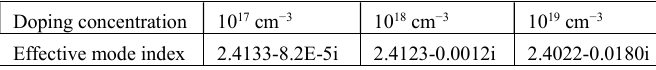
Table 1. Effective mode index for three different erbium doping levels of the silicon waveguide.